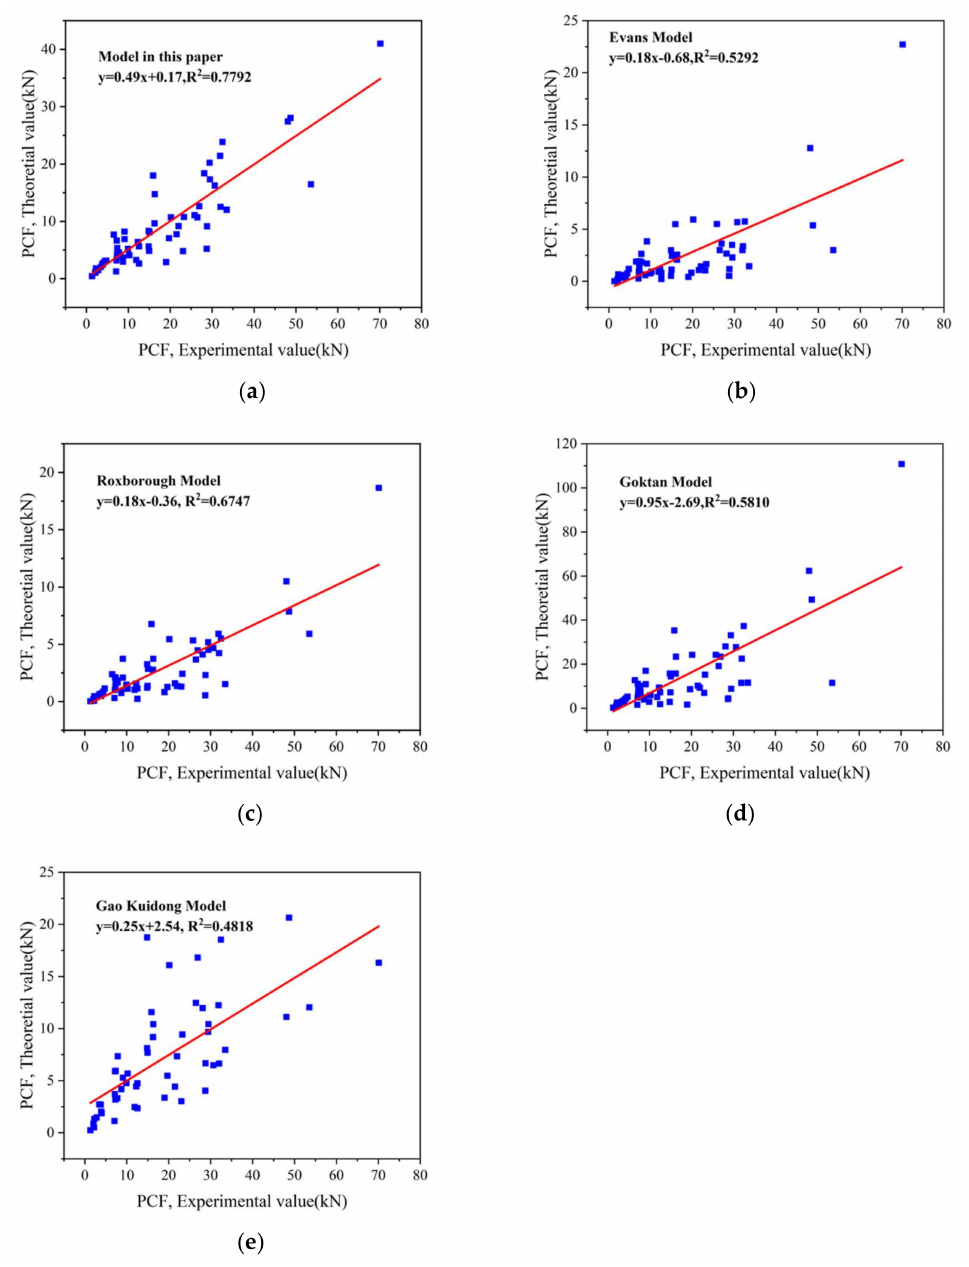
Figure 7. The relationship between theoretical model calculation results and experimental results for the first prediction performance analysis. ( a ) Theoretical model of peak cutting force in this paper; ( b ) Evans model; ( c ) Roxborough model; ( d ) Goktan Semi-empirical model; ( e ) Gao Kuidong model. Table 8 and Figure 8 reflect the variation of the coefficient of determination for each model in the three analyses. In the three analyses, the number of rock samples gradually increased from 9 to 27, and the proposed model in this paper always maintains the strongest linear correlation compared with other models. Besides, when the number of rock samples increases, as a result of the large fluctuation of PCF when cutting hard rocks, the correlation of all five theoretical models showed a decreasing trend, but the correlation of this model decreases the least after three analyses, and the R 2 only decreases by 13.93% while the other models decrease by more than